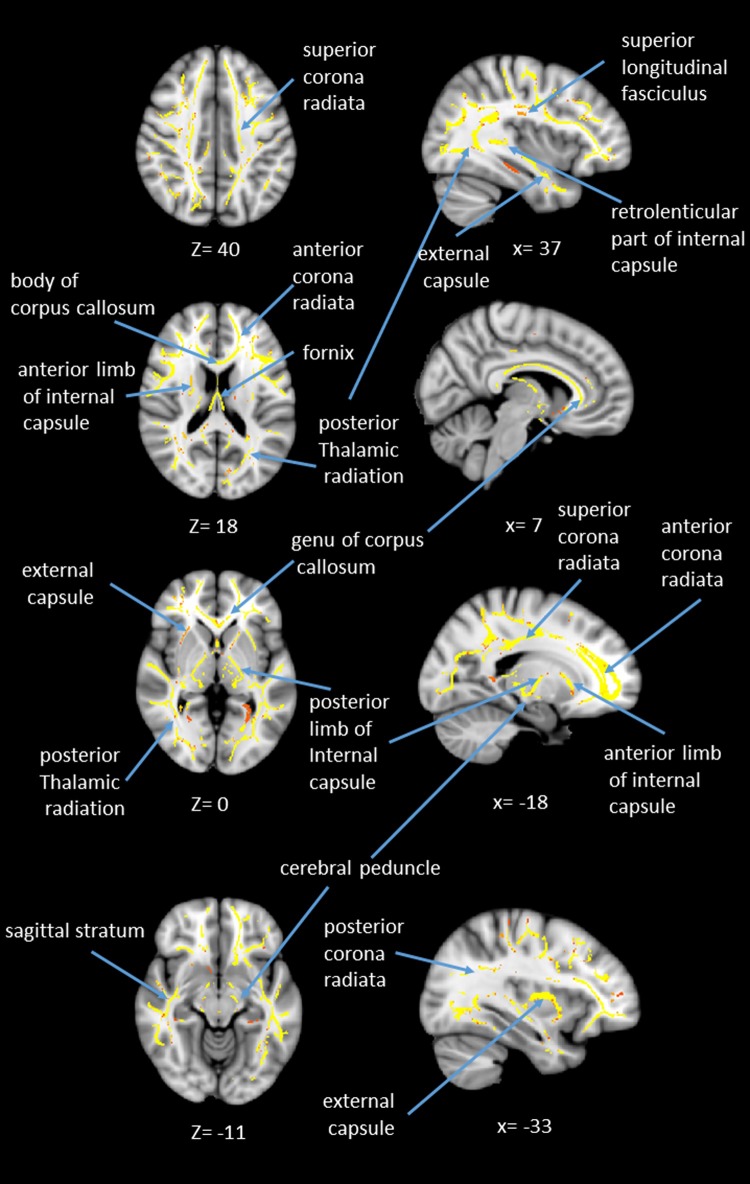
Statistical map showing white matter clusters (red-yellow) where fractional anisotropy (FA) was significantly correlated with age, across four axial slices (left column) and four sagittal slices (right column).Axial slices are presented in radiological orientation (right = left).